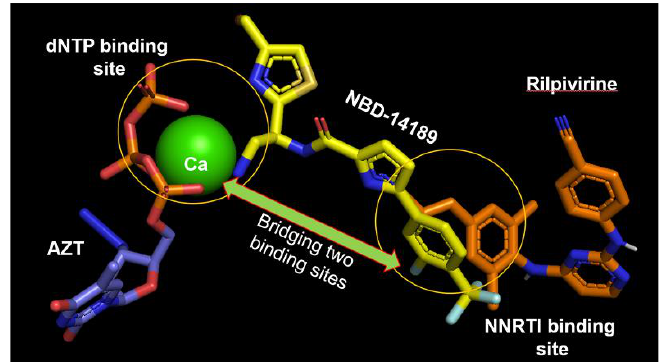
Figure 1. Superposition of RT/NBD-14189 (PDB: 7LPW [14]), RT/Riplivirine (PDB: 4G1Q [17]), and RT/AZT-TP/calcium ion (PDB: 5I42 [18]) shows that NBD-14189 bridges the binding site of dNTP and NNRTI.